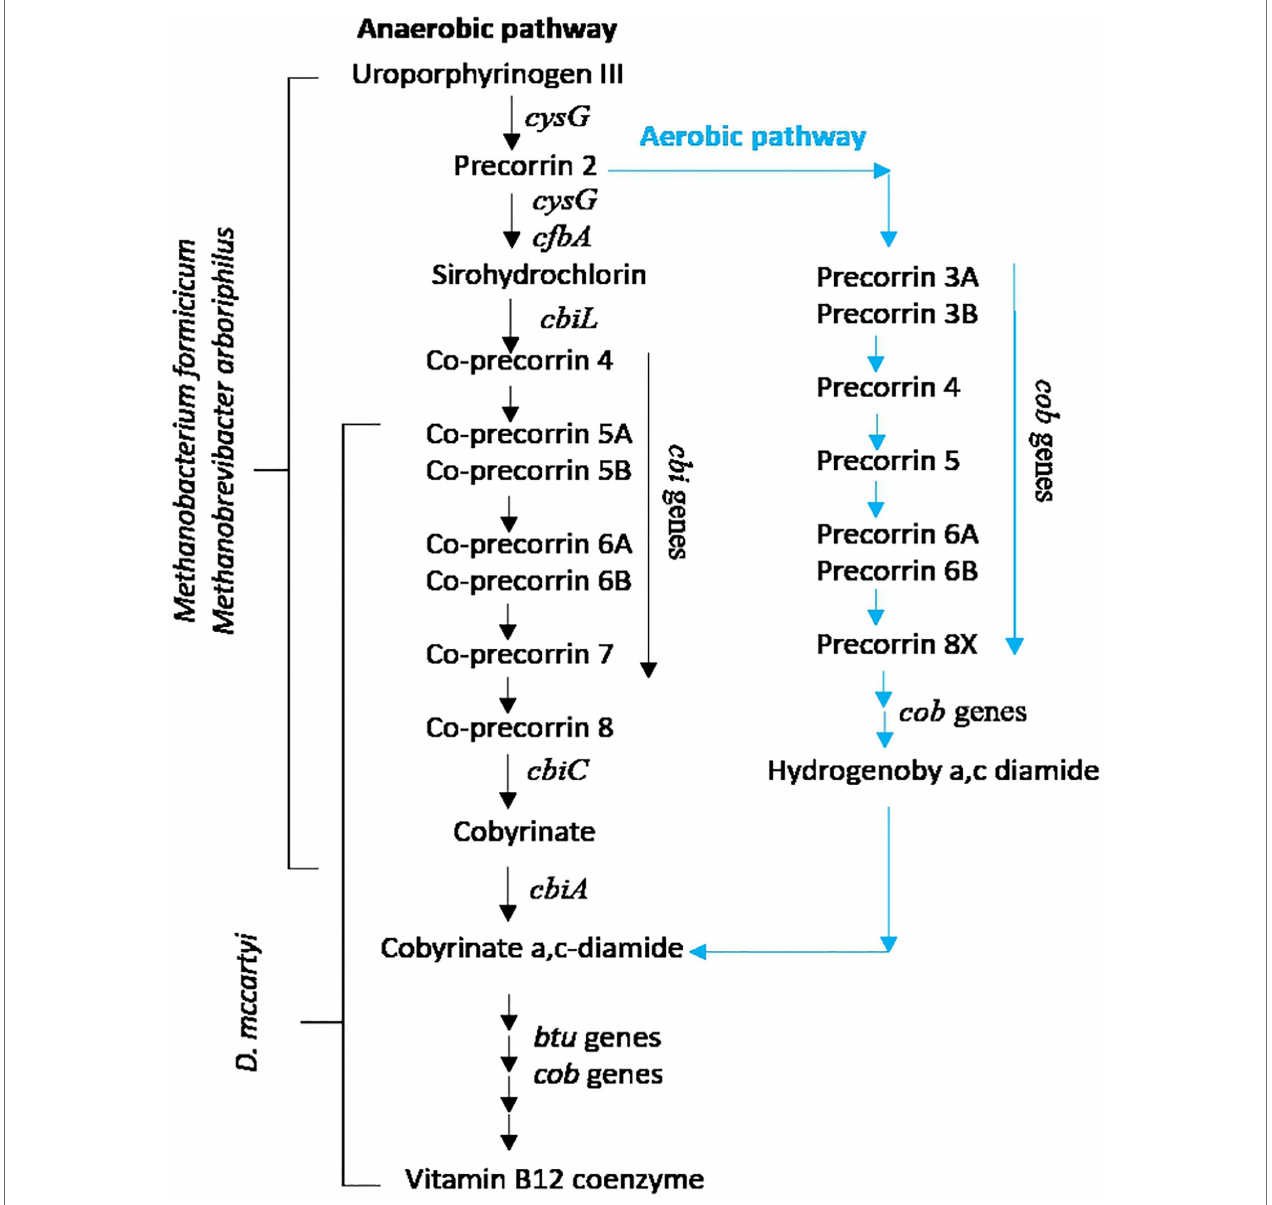
FIGURE 6 | Upstream (KEGG: M00924) and downstream (KEGG: M00122) corrinoid biosynthesis pathways of vitamin B12